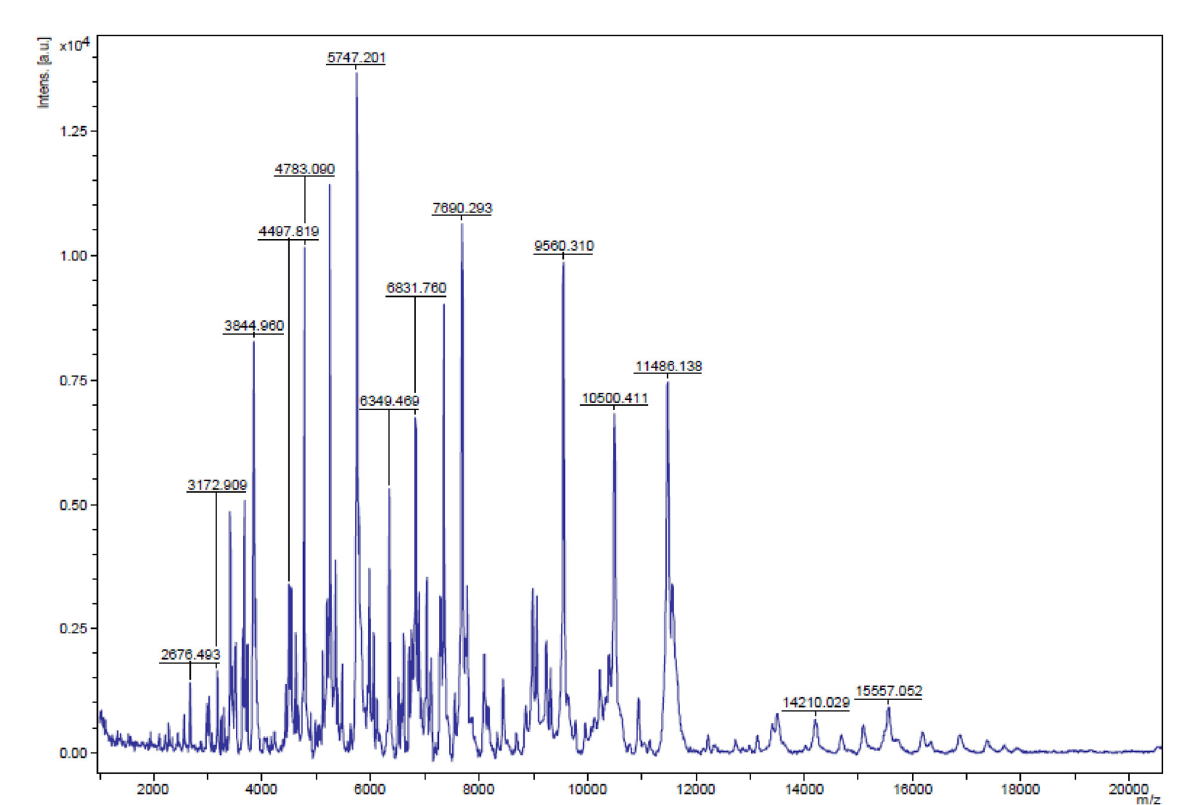
FIGURE1 Result of the matrix-assisted laser desorption ionization time-of-flight mass spectrometry (MALDI-TOF MS) analysis. The MALDI-TOF MS showed that the isolated strain of E. faecium that possess antimicrobial activity was initially identified with a high confidence value of 2.31 that indicated a reliable identification of the isolate up to species